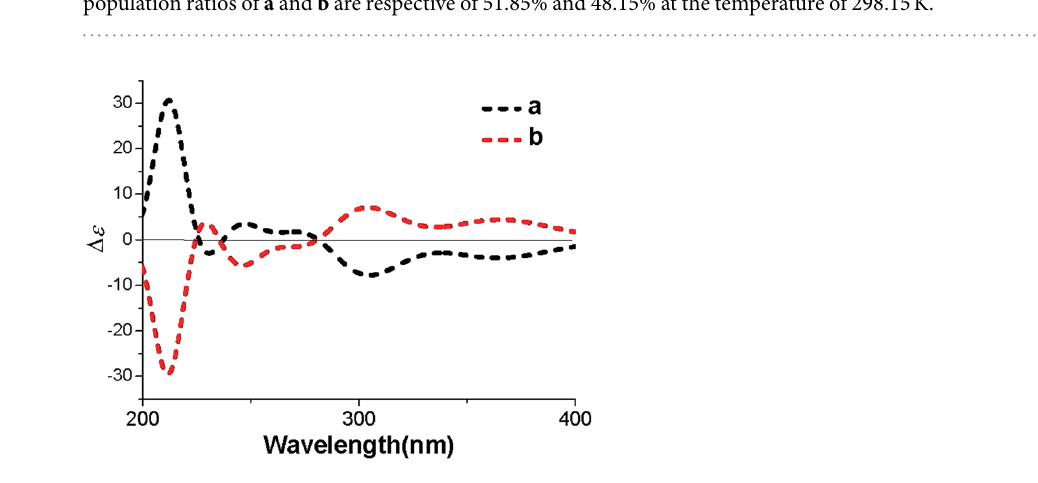
Figure 3. The two conformers (( a ) and ( b )) of hydroquinone-2-pyridone ( Δ E = 0–5 kcal/mol). The Boltzman population ratios of a and b are respective of 51.85% and 48.15% at the temperature of 298.15 K.